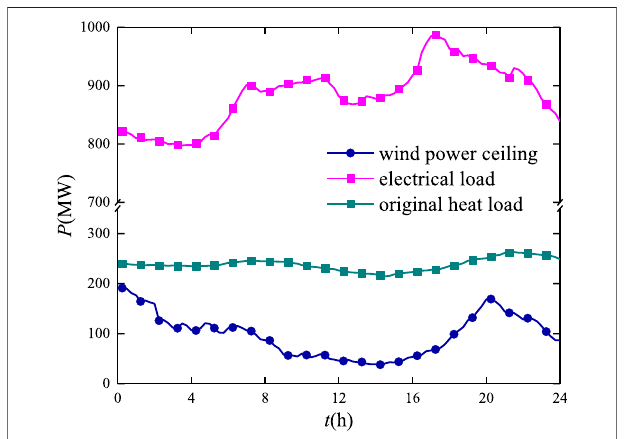
FIGURE 6 | Variations of ambient temperature and COP in atypical